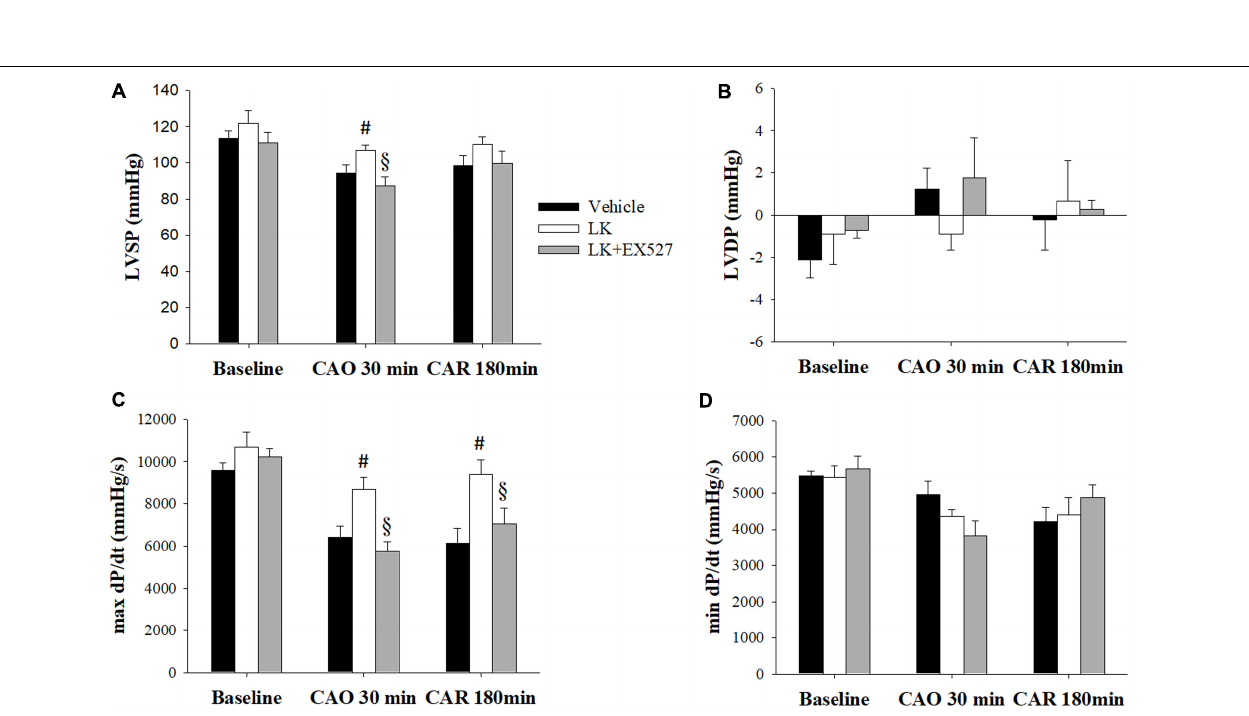
Frontiers in Pharmacology |